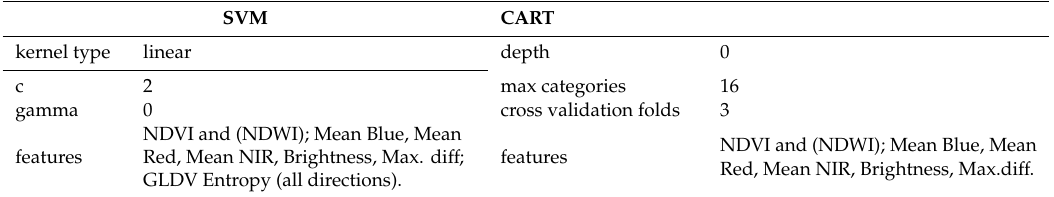
Table 3. Parameters of the SVM and CART methods.